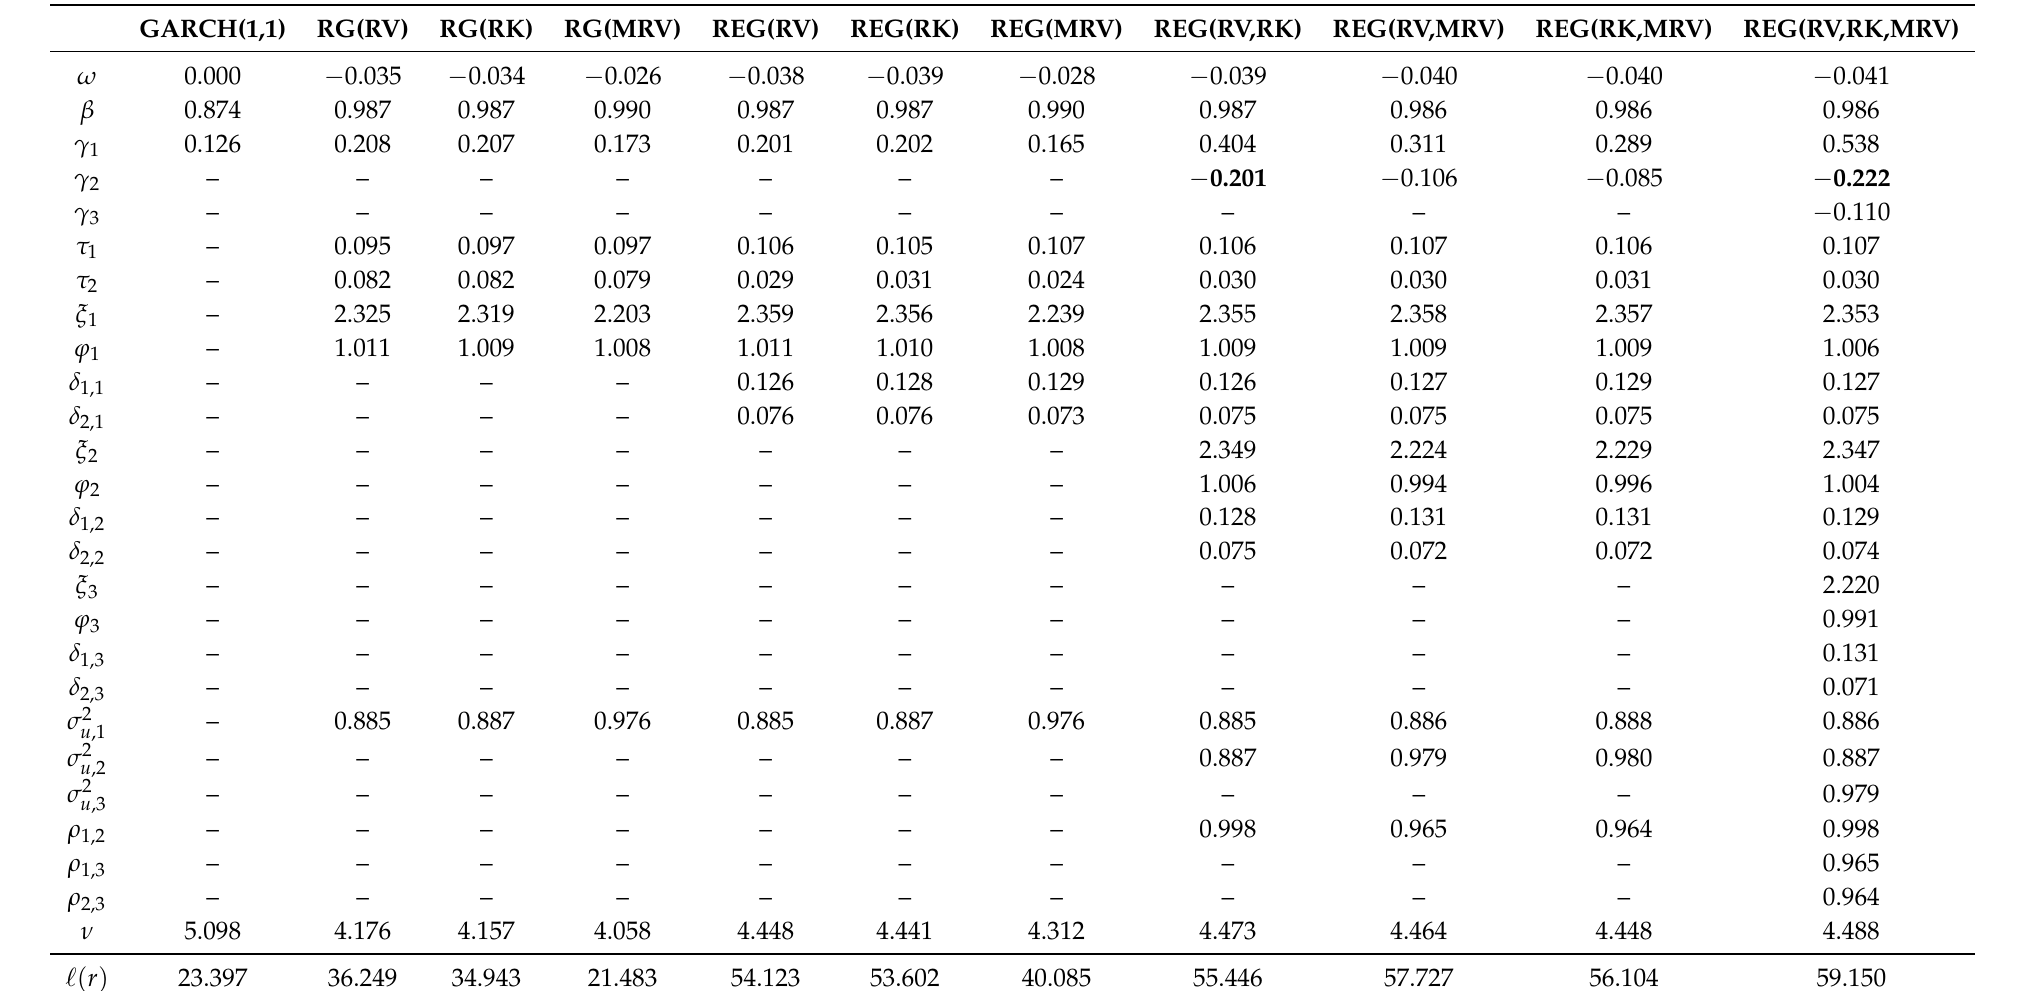
Table 4. VIC in-sample parameter